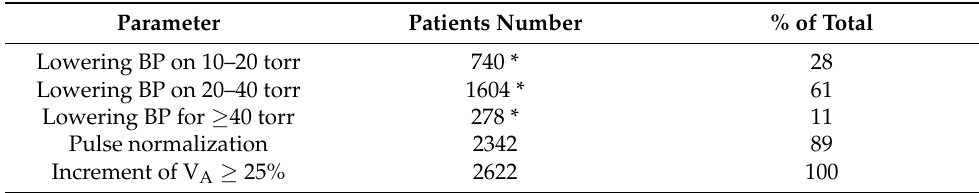
Table 1. Results on the restoration of vertebral arteries V A by cervical cartilage recovery according to [24,25]. The data was collected for the entire